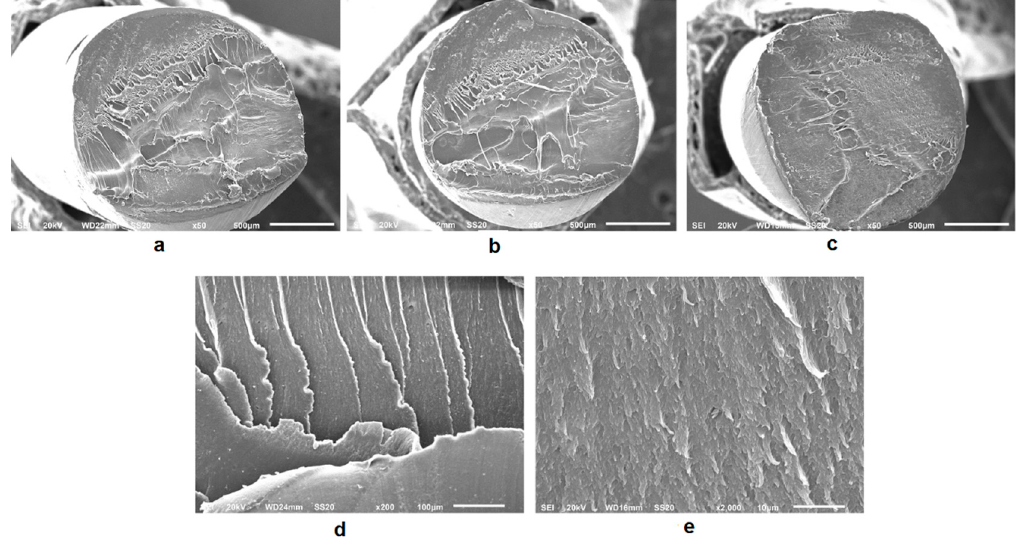
Figure 1. Cross-sectional images for printing wires (×50): ( a ) Polylactic acid (PLA); ( b ) PLA 3D850 and ( c ) PLA-Graphene filaments; ( d , e ) Enlarged PLA-Graphene views (200 × and 2000 × , respectively).